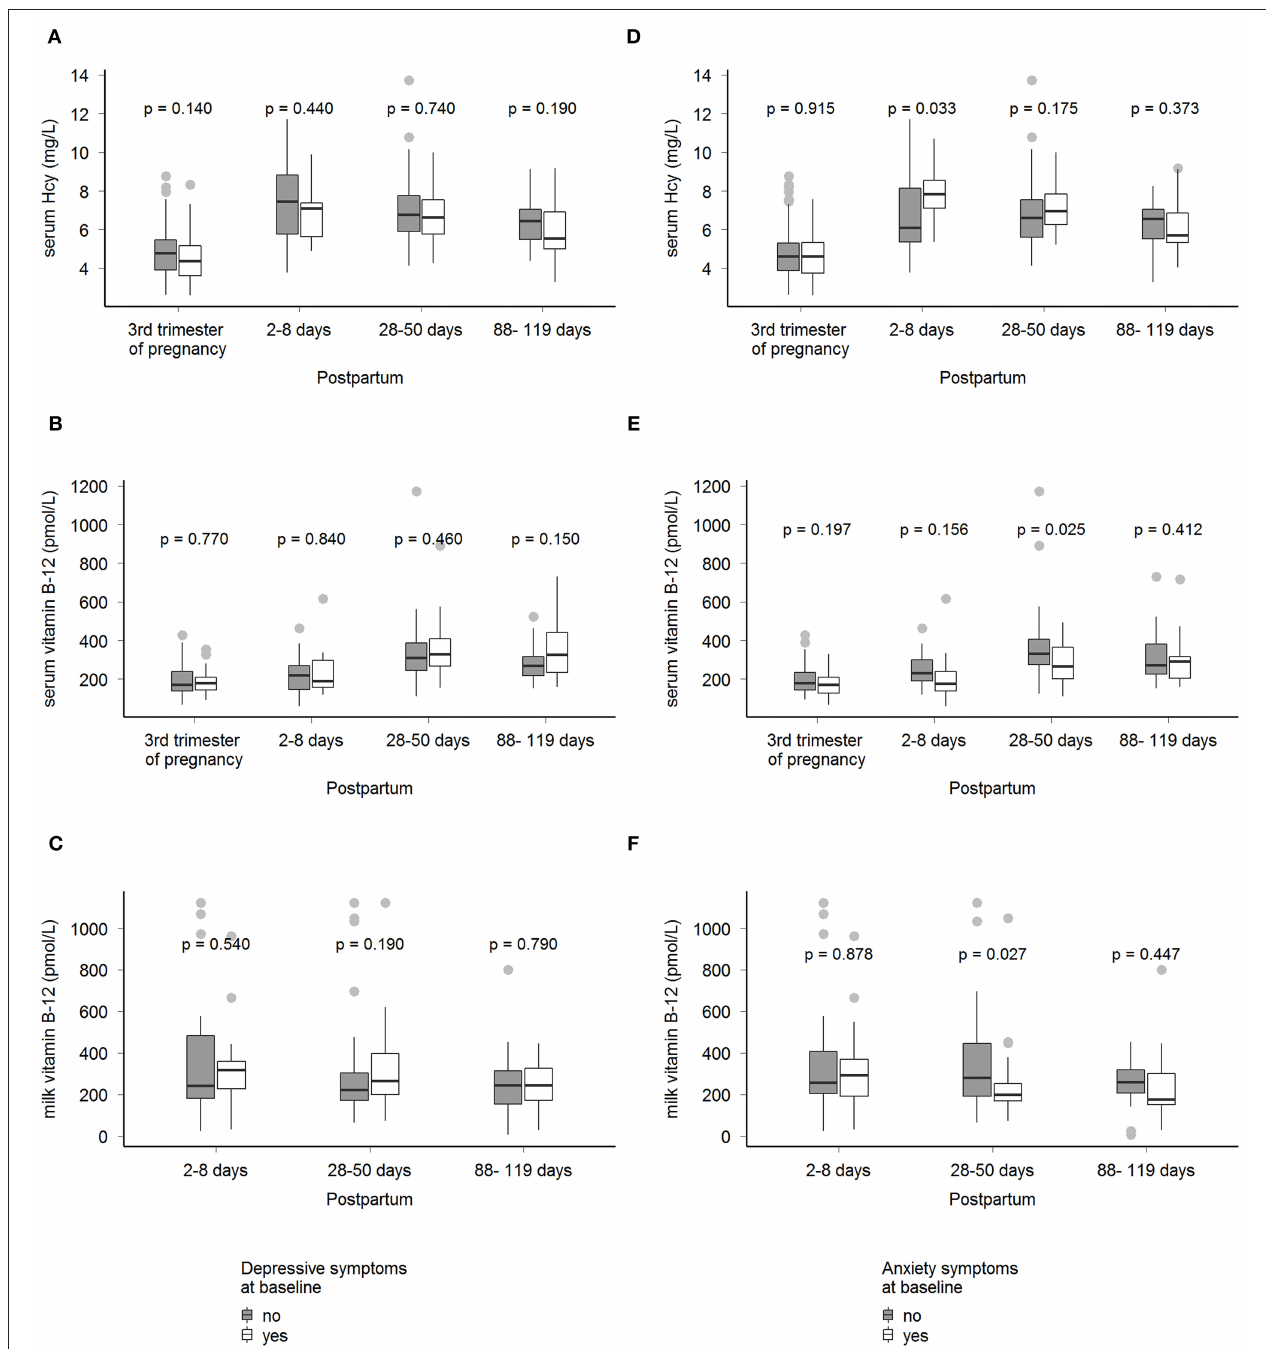
FIGURE 1 | Median concentrations of serum B-12, serum homocysteine, and milk B-12 by maternal mental health status in Rio de Janeiro, Brazil. Mann–Whitney’s test was performed to compare medians (IQR) of biological samples (serum vitamin B-12, serum homocysteine, and milk vitamin B-12) at the 3rd trimester of pregnancy, 2-8 d, 28-50 d, and 88-119 d postpartum between women with and without depressive or anxiety symptoms at 3rd trimester of pregnancy (baseline), p < 0.05. Depressive symptoms were assessed by the Edinburgh Postnatal Depression Scale (EPDS), yes (EPDS ≥ 11, n = 36) and no (EPDS < 11, n = 65) (A–C) . Anxiety state was assessed by the State-Trait Anxiety Inventory (STAI), yes (STAI ≥ 40, n = 40), and no (STAI < 40, n = 61) (D–F) . Hcy, homocysteine. and stored at − 80 ◦ C until analysis. Serum B-12